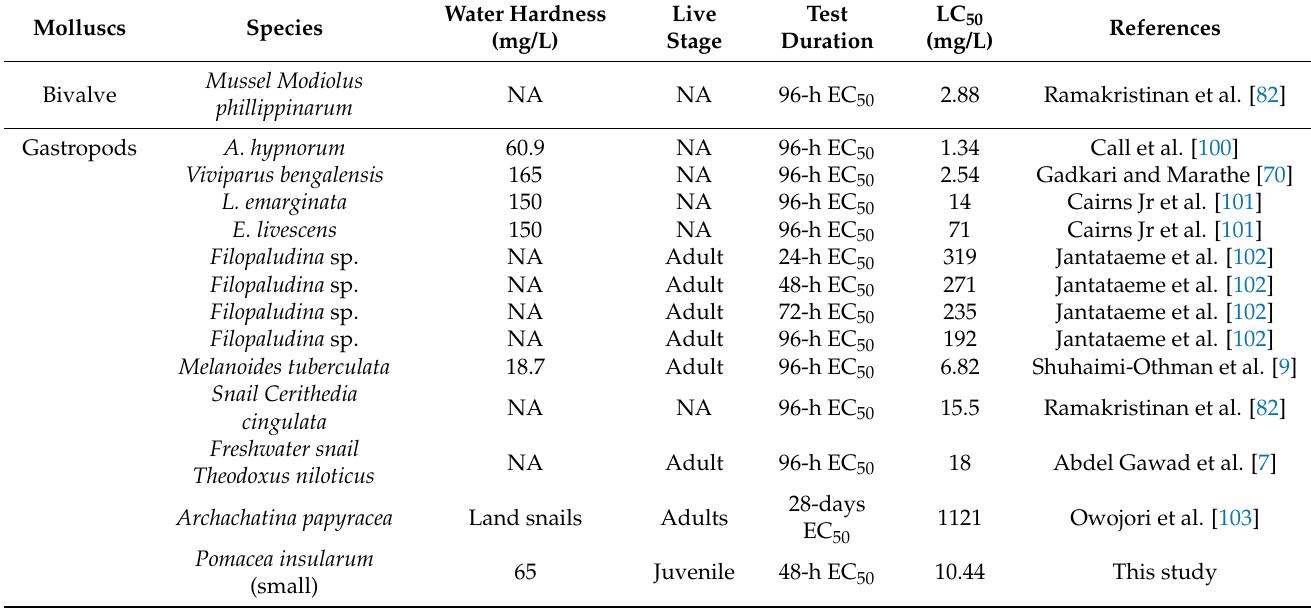
Table 5. Comparison of LC 50 values (mg/L) of Pb in Pomacea insularum with other mollusks reported in the